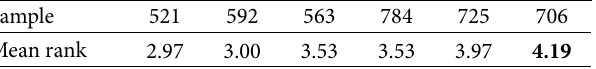
. The mean ranking of the sensory scores were determined using 푛 = 35 the Friedman test. The value in bold represents the sample with the highest mean rank. Friedman test is a ranking system to find the sample with the best sensory attributes. So according to the results sample 706 portrays the best rank. Since this is a ranking system, significance is not calculated.